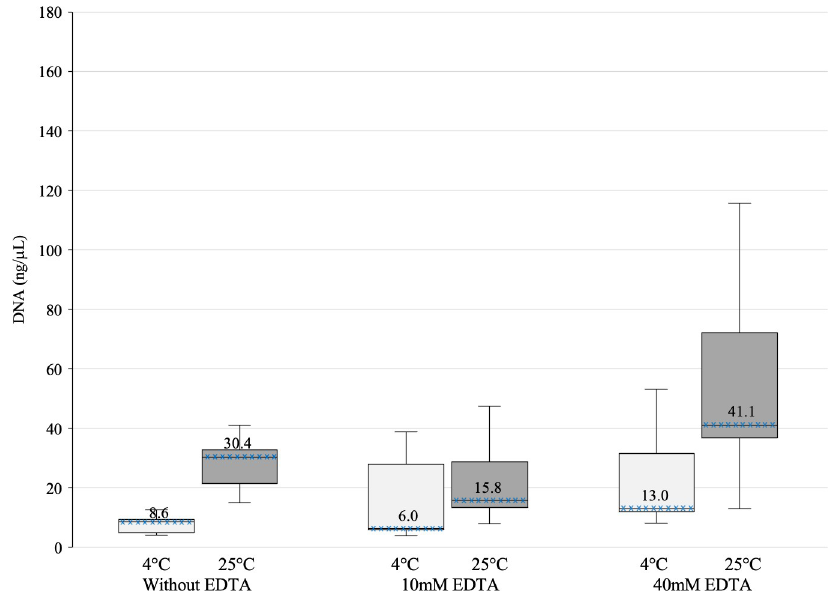
Fig 4. DNA concentration in samples stored in different EDTA concentrations and temperatures. The top of the box represents the upper quartile (p75), the bottom the lower quartile (p25), and the x-patterned line the median (p50), the median is identified above the line. The upper and lower whiskers extend to 1.5 times the interquartile range. The best DNA concentrations resulted from EDTA at 40mM, both at 25˚C and 4˚C. The best storage temperature was 25˚C compared to 4˚C, regardless of EDTA concentration. DNA extraction and quantification presented for this particular experiment were performed 24 hours after collection.